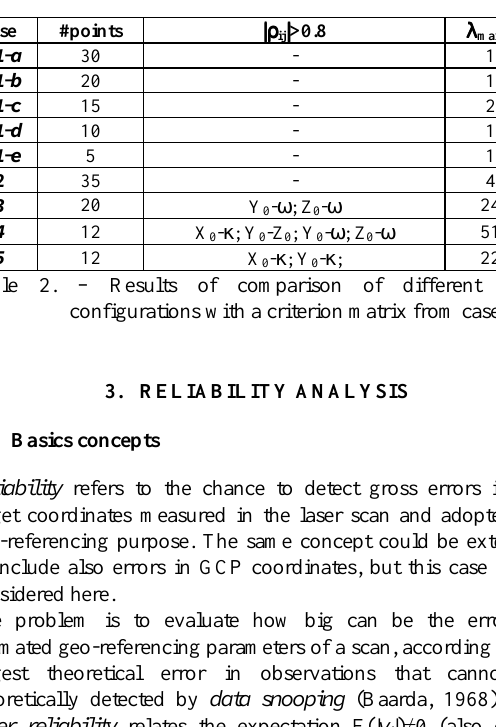
In general, computed residuals on check points have resulted smaller in the second subset than in the first group, as expected.